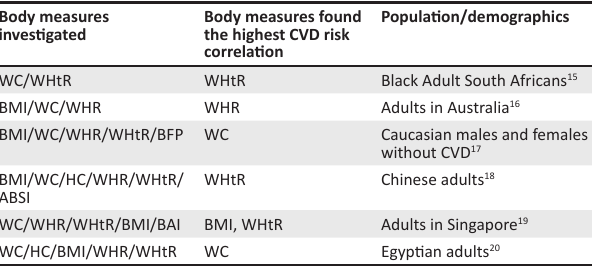
TABLE 1: Summary of body measures that have been investigated in different populations as predictors of cardiovascular disease risk. Body measures